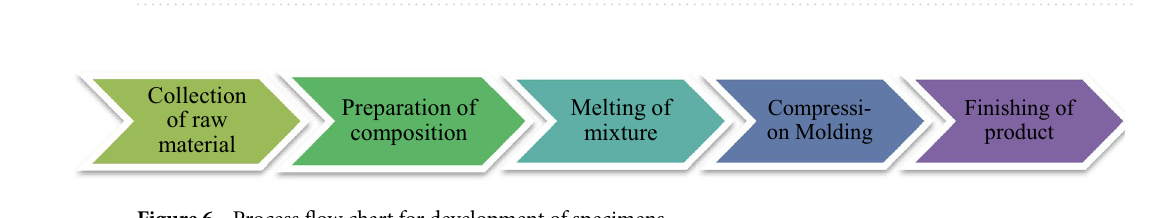
Figure 6. Process flow chart for development of specimens.